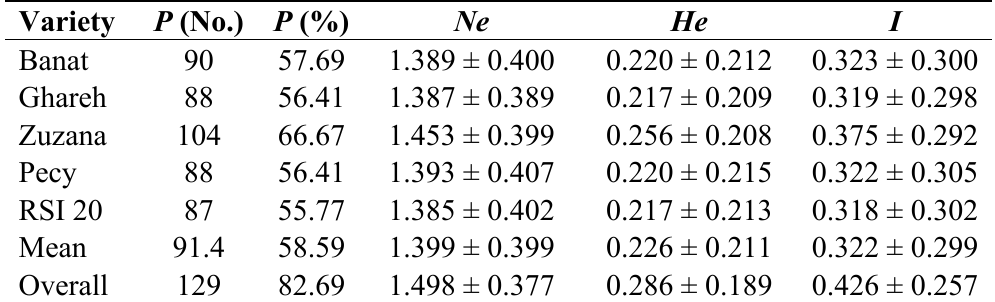
Table 3. Estimates of genetic variation in alfalfa varieties using RAPD markers.